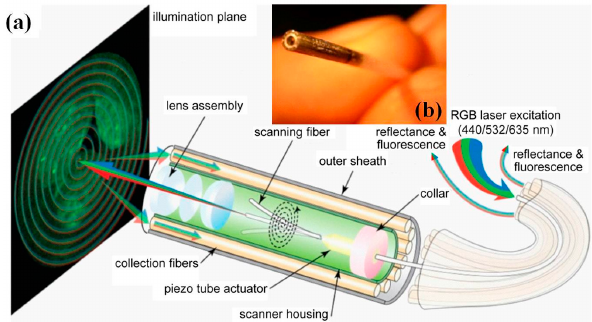
Figure 24. Scanning fiber endoscopy (SFE) for wide-field multiplexed fluorescent imaging. ( a ) Schematic diagram of the SFE with the scanning illumination fiber moving in the spiral scan pattern, a magnified view of the coaxial scanner design is shown, which consists of the central single-mode optical fiber that is cantilevered from the tip of a tubular piezoelectric actuator, held by a mounting collar. ( b ) Photograph of the OD 1 mm catheter endoscope scanhead (Reproduced with permission from SPIE [124]).